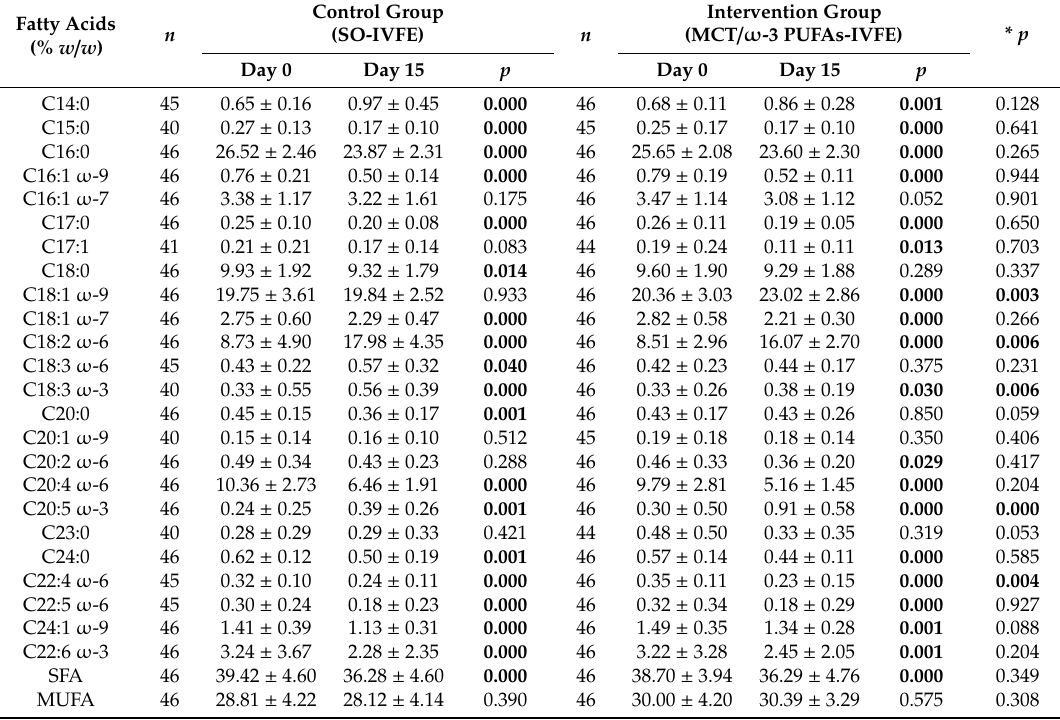
Table 3. Di ff erences in serum fatty acid profile at baseline (day 0) and at the endpoint of intervention (day